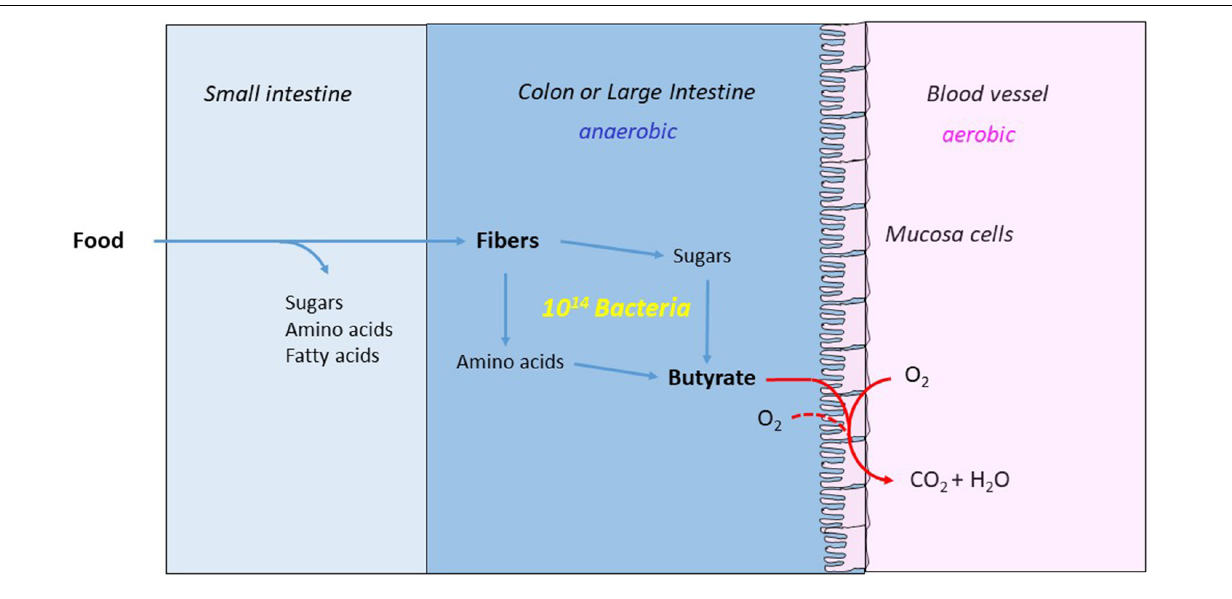
FIGURE 6 | Butyrate nourishes the mucosa cells and makes the colon anaerobic. The major part of the food is digested and absorbed in the small intestine. The remaining fibers are hydrolyzed to monosaccharides and amino acids by the anaerobic bacteria and fermented the large intestine or colon to acetate, propionate and butyrate. The mucosa cells combust the produced butyrate with oxygen from blood and colon, whereby the colon becomes strictly